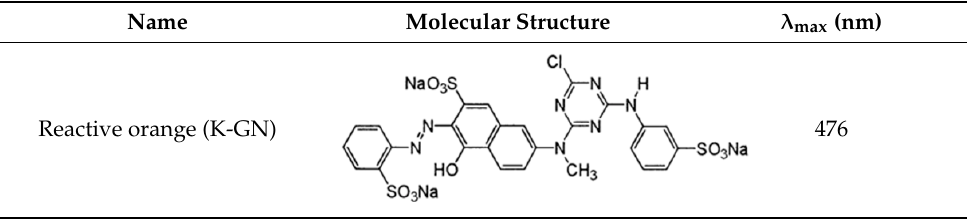
Table 1. Reactive orange characteristics.